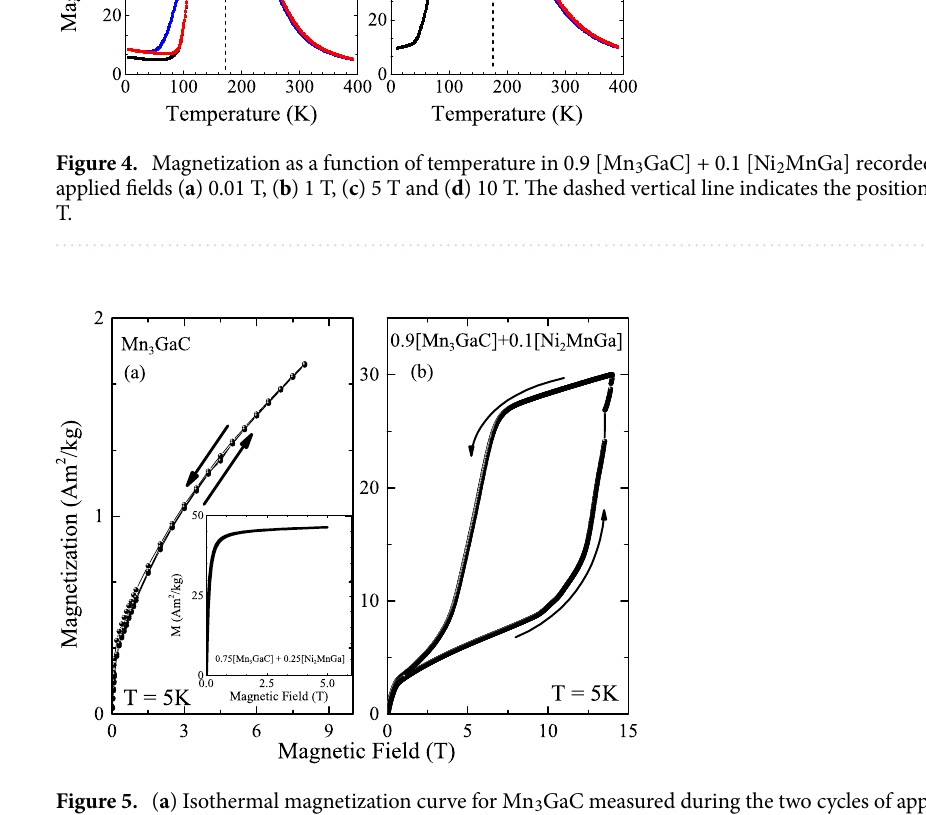
Figure 5. ( a ) Isothermal magnetization curve for Mn 3 GaC measured during the two cycles of applied magnetic field ( 0 T ≤ H ≤ 8 T ). Inset shows M(H) loop at 5 K for the first two cycles in 0.75 [Mn 3 GaC] + 0.25 [Ni 2 MnGa]. ( b ) Isothermal magnetization curve recorded at T = 5 K for 0.9 [Mn 3 GaC] + 0.1 [Ni 2 MnGa] during increasing and decreasing magnetic field from 0 T to +14